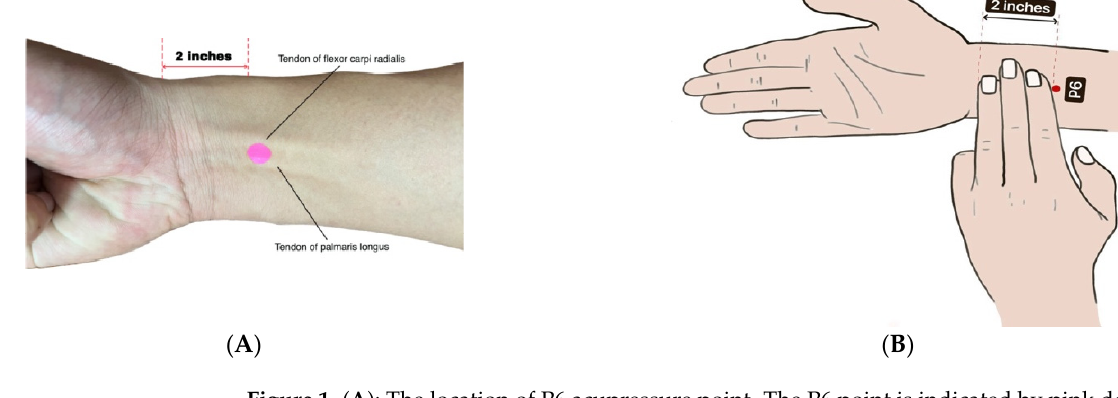
Figure 1. ( A ): The location of P6 acupressure point. The P6 point is indicated by pink dot. Red line represents the distance of 2 inches, which is proximal to the distal wrist crease. The tendons of flexor carpi radialis and tendon of palmaris longus are as labelled. ( B ) A schematic diagram showing the location of P6 point.